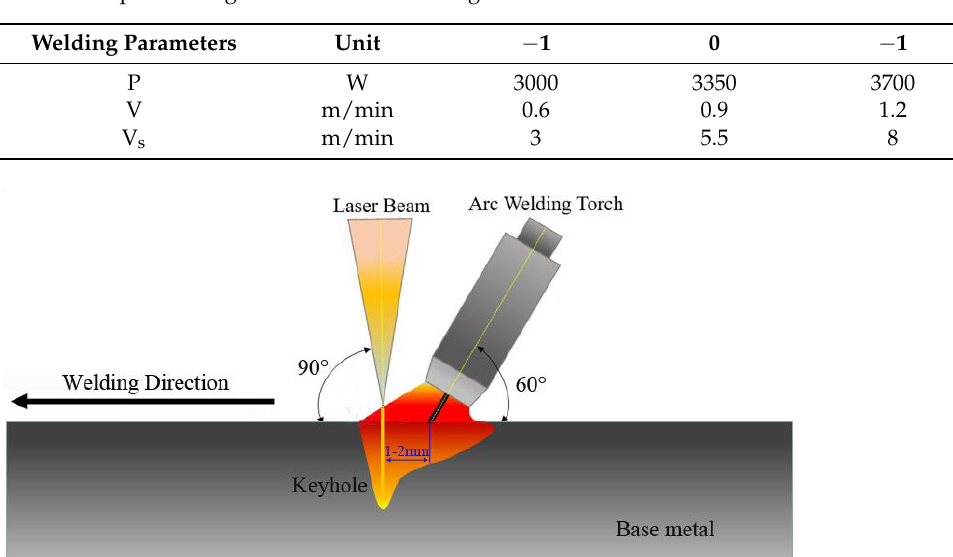
Table 4. Response design level value and coding value.